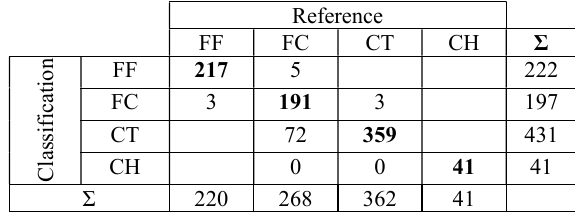
Table 4 . Matrix of confusion of the algorithm Random Forest.